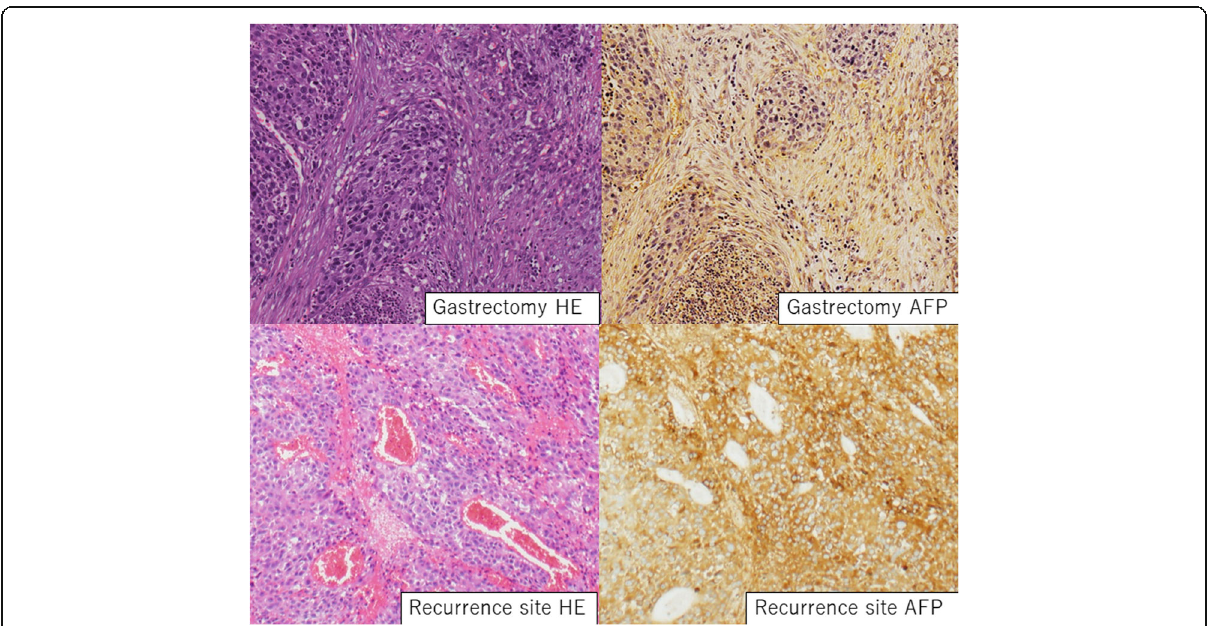
Fig. 2 Microscopic findings. Pathological examination indicated that the tumor cells had selling nucleus and acidophilic cells with alveolar growth pattern. Additionally, immunohistochemical examination indicated AFP positivity of the tumor cells, similar to the pathological features of primary gastric cancer resected 15 years ago